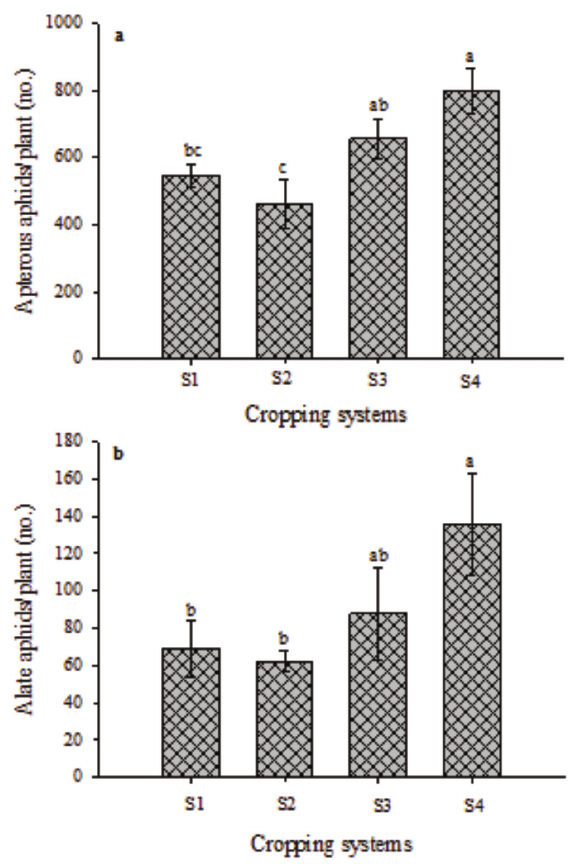
Figure 2 - Mean numbers (±SE) of apterous (a) and alate (b) Aphis gossypii (Hemiptera: Aphididae) in the cropping systems of cotton (S4) and cotton intercropped with cowpea systems (S1, S2, and S3). Each column represents the mean number of insects found in 25 plants. Error bars indicate SE. Within each figure, different letters indicate differences (SNK test; P =